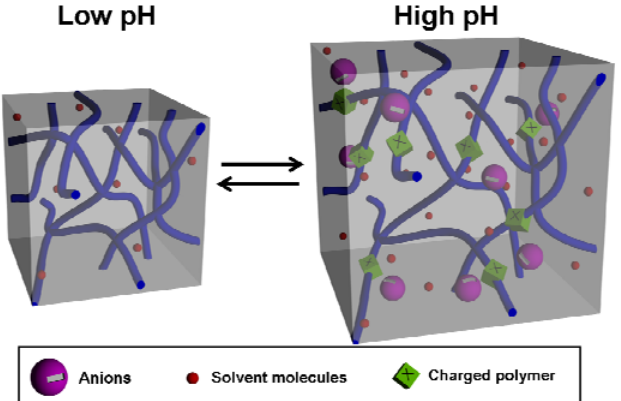
Figure 1. Illustration of a volume transition in a cross-linked polybase network triggered by a pH